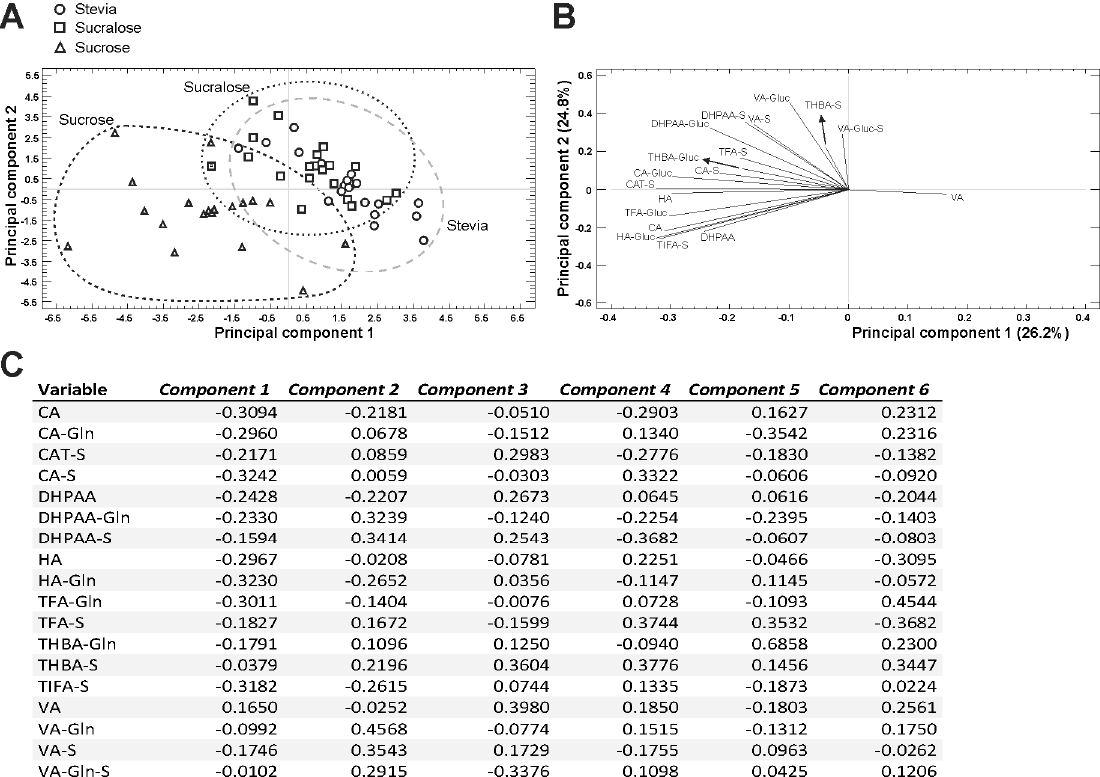
Figure 2. Principal component analysis (PCA) of the urine metabolites of anthocyanins ingested through newly developed citrus-maqui juices using di ff erent sweeteners (stevia, sucralose, and sucrose). Dot plot indicating the samples classification for the two first Principal Components Score plots ( A ), loading plot showing eigenvectors for the two principal components that account for at least 50.0% of the total variance ( B ), and Table indicating the components weights ( C ). CA, ca ff eic acid; CA-Gln, ca ff eic acid-glucuronide; CAT-S, catechol-sulfate; CA-S, ca ff eic acid-sulfate; DHPAA, 3,4-dihidroxifenilacetic acid; DHPAA-Gln, 3,4-dihidroxifenilacetic acid-glucuronide; DHPAA-S, 3,4-dihidroxifenilacetic acid-sulfate; HA, hippuric acid; HA-Gln, hippuric acid-glucuronide; TFA-Gln, trans -ferulic acid-glucuronide, TFA-S, trans -ferulic acid-sulfate, THBA-Gln, 2,4,6-trihidrobenzaldehid-glucuronide, THBA-S, 2,4,6-trihidrobenzaldehid-sulfate; TIFA-S, trans -isoferulic acid-sulfate; VA, vanillic acid; VA-Gln, vanillic acid-glucuronide, VA-S, vanillic acid-sulfate, VA-Gln-S, vanillic